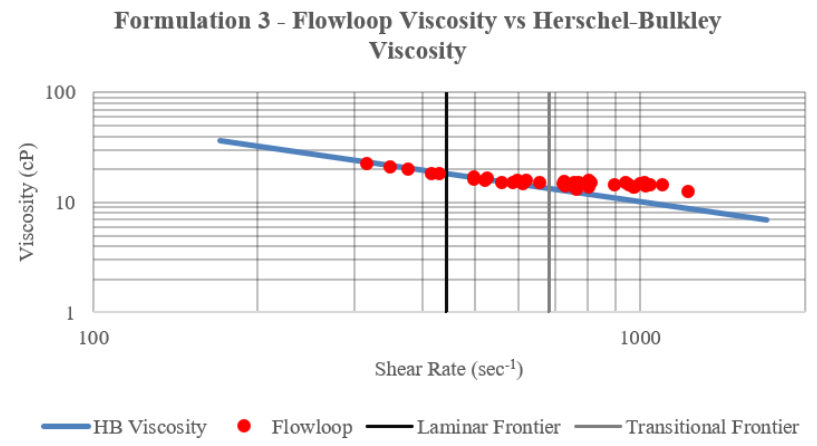
Figure 13: Formulation 3 - Flowloop Viscosity vs Herschel-Bulkley